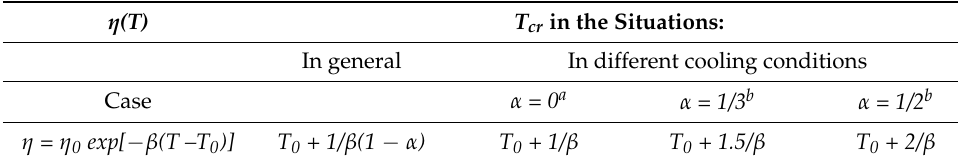
Table 2. Expressions of T cr at which M f is at its maximum